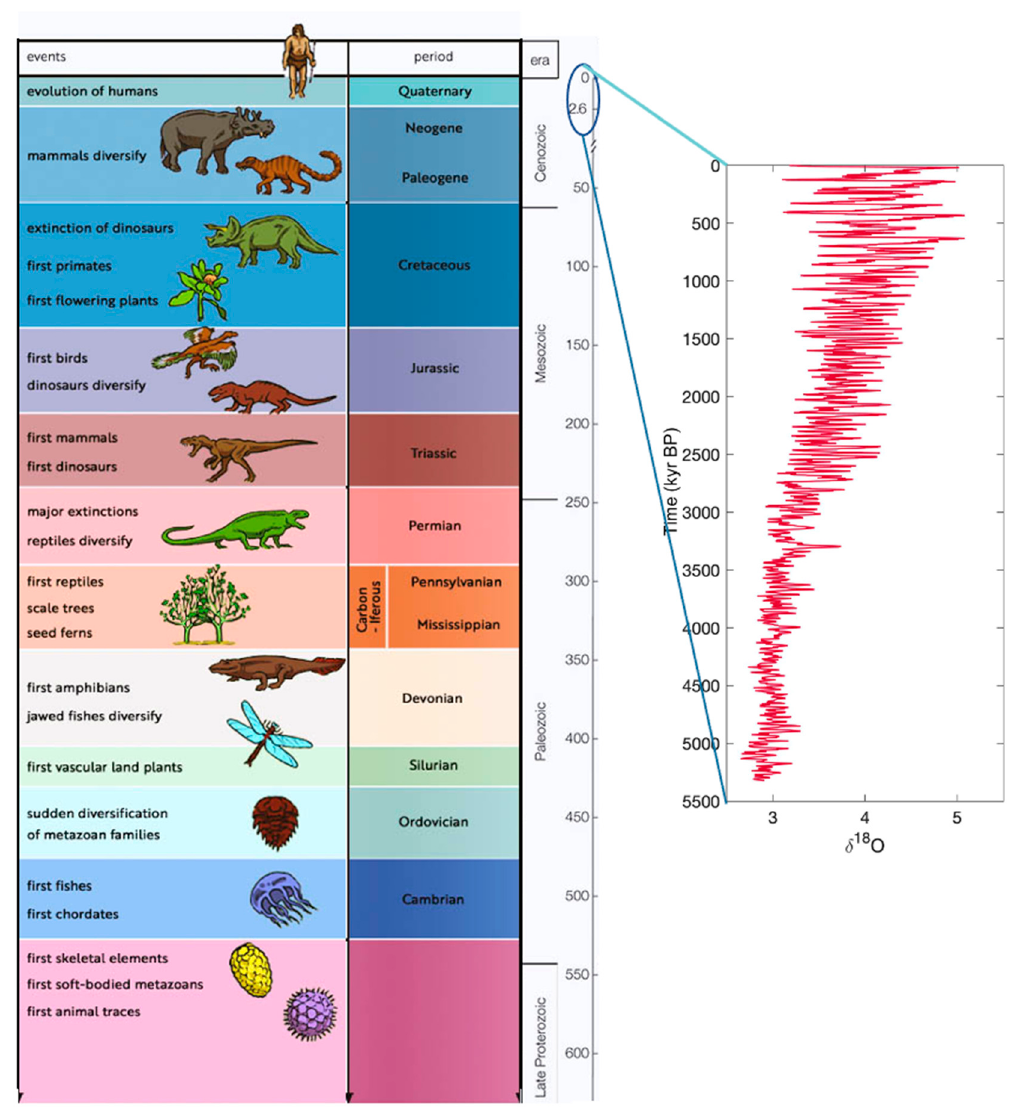
Figure 1. Geological scale and scheme of life evolution on the planet during the last 630 M years before present (BP) (on the left) with a zoom on the last 5.5 M years BP that reports the time behavior of the 𝛿 (cid:2869)(cid:2876) O concentration (on the right) [26].